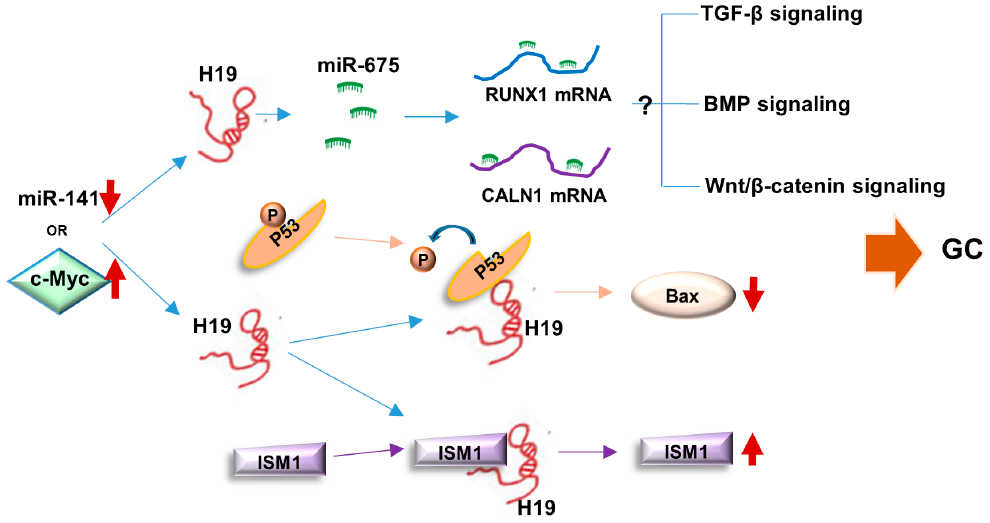
Figure 4. Summary of molecular mechanisms of H19 in GC development. On the one hand, miR-675 derived from H19 can target and degrade RUNX1 and CALN1 mRNA to enhance GC development via influencing potential signaling pathways. On the other hand, H19 binds with p53 to inhibit its activity and decrease BAX. H19 can also bind to ISM1 to induce ISM1 stabilization. The downregulation of miR-141 and c-Myc activation can up-regulate H19 expression in gastric tumorigenesis. GC, gastric cancer; up arrow, upregulation; down arrow, downregulation.